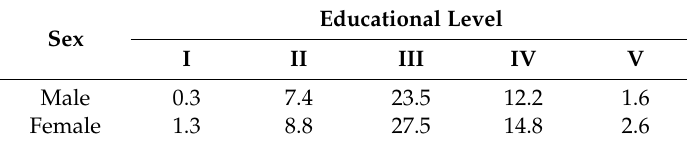
Table 2. Sample distribution (% of total) by sex and educational level.